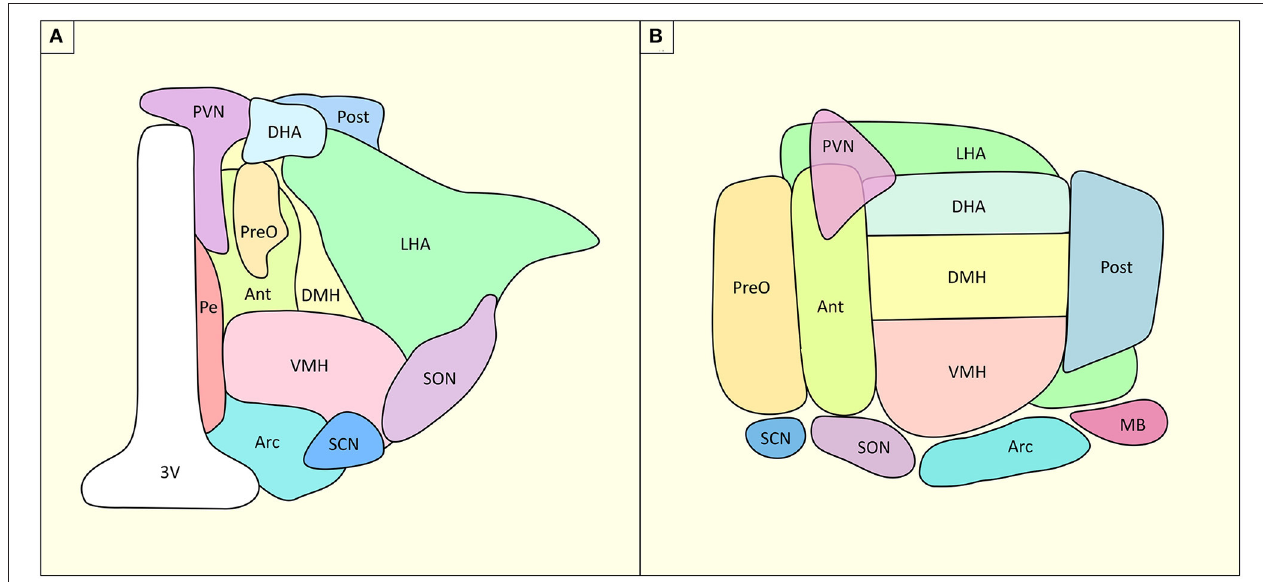
FIGURE 1 | Structural organization of HT and its nuclei. (A) Coronal slice of the hypothalamus, (B) Sagittal slice of the hypothalamus. Ant, anterior hypothalamus; Arc, arcuate nucleus, DHA, dorsal hypothalamic area; DMH, dorsomedial hypothalamus; LHA, lateral hypothalamic area; MB, mammillary body; Pe, periventricular nucleus; Post, posterior hypothalamic nucleus; PreO, preoptic nucleus; PVN, paraventricular nucleus; SCN, suprachiasmatic nucleus; SON, supraoptic nucleus; VMH, ventromedial hypothalamus; 3V, third ventricle. Based on (4,